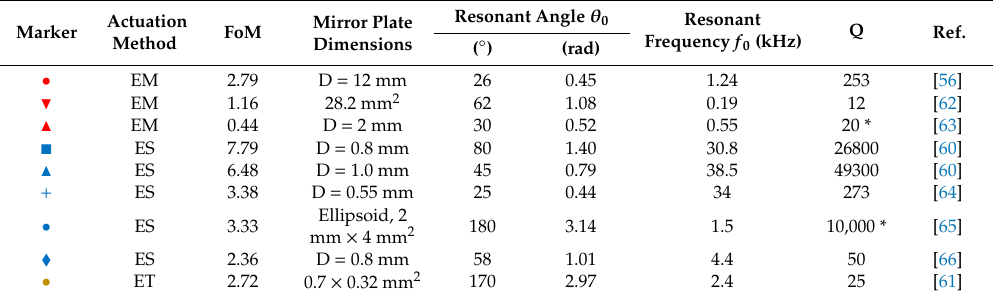
Table 2. The FoMs of 1D resonant scanning MEMS mirrors.